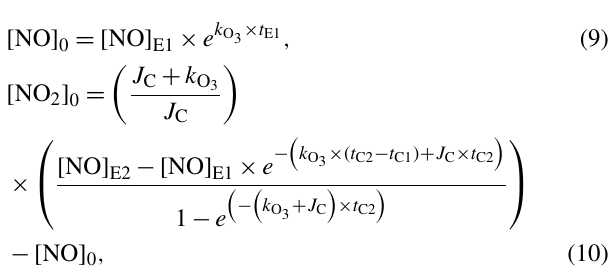
a The percentage standard deviation for each measurement cycle is determined as the standard deviation of a cycle divided by the mean of the same cycle. b Extreme measurements are determined to be mixing ratios that are outside the hourly mean ± 4 standard deviations of the hourly mixing ratio. c Extreme differences between the hourly mean and median of the mixing ratios are determined to be differences outside the hourly mean ± 4 standard deviations of the differences between the mean and